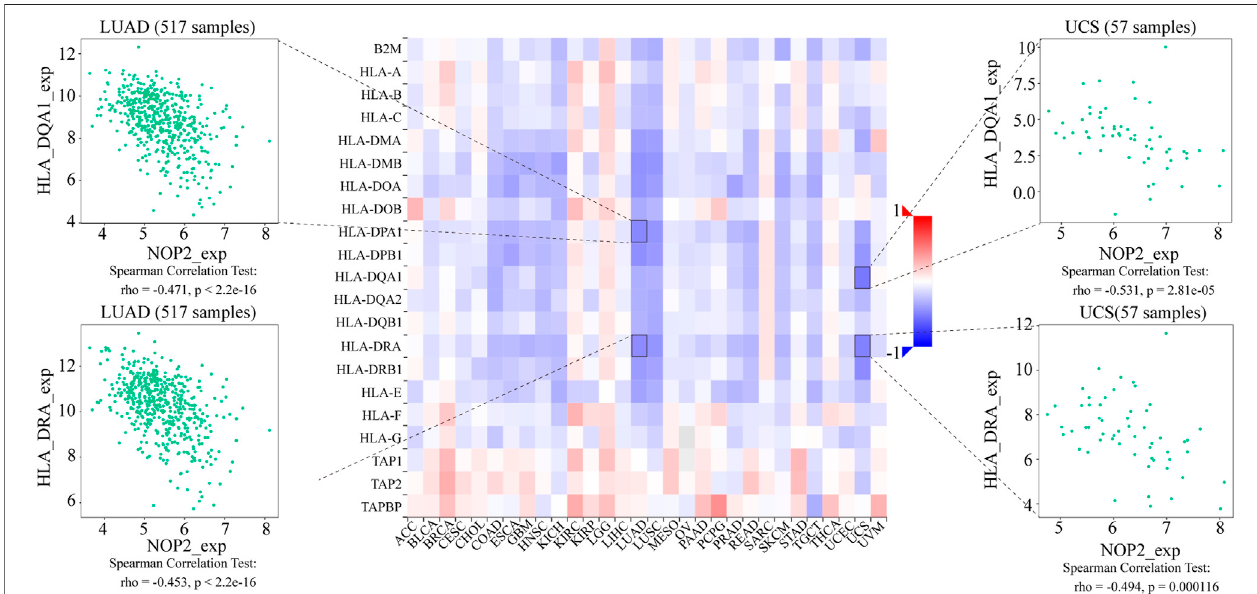
FIGURE 8 | Expression correlation between NOP2 and MHC molecules. Red indicates positive correlation, whereas blue indicates negative correlation. The top four strongest associations are displayed via dot plots.